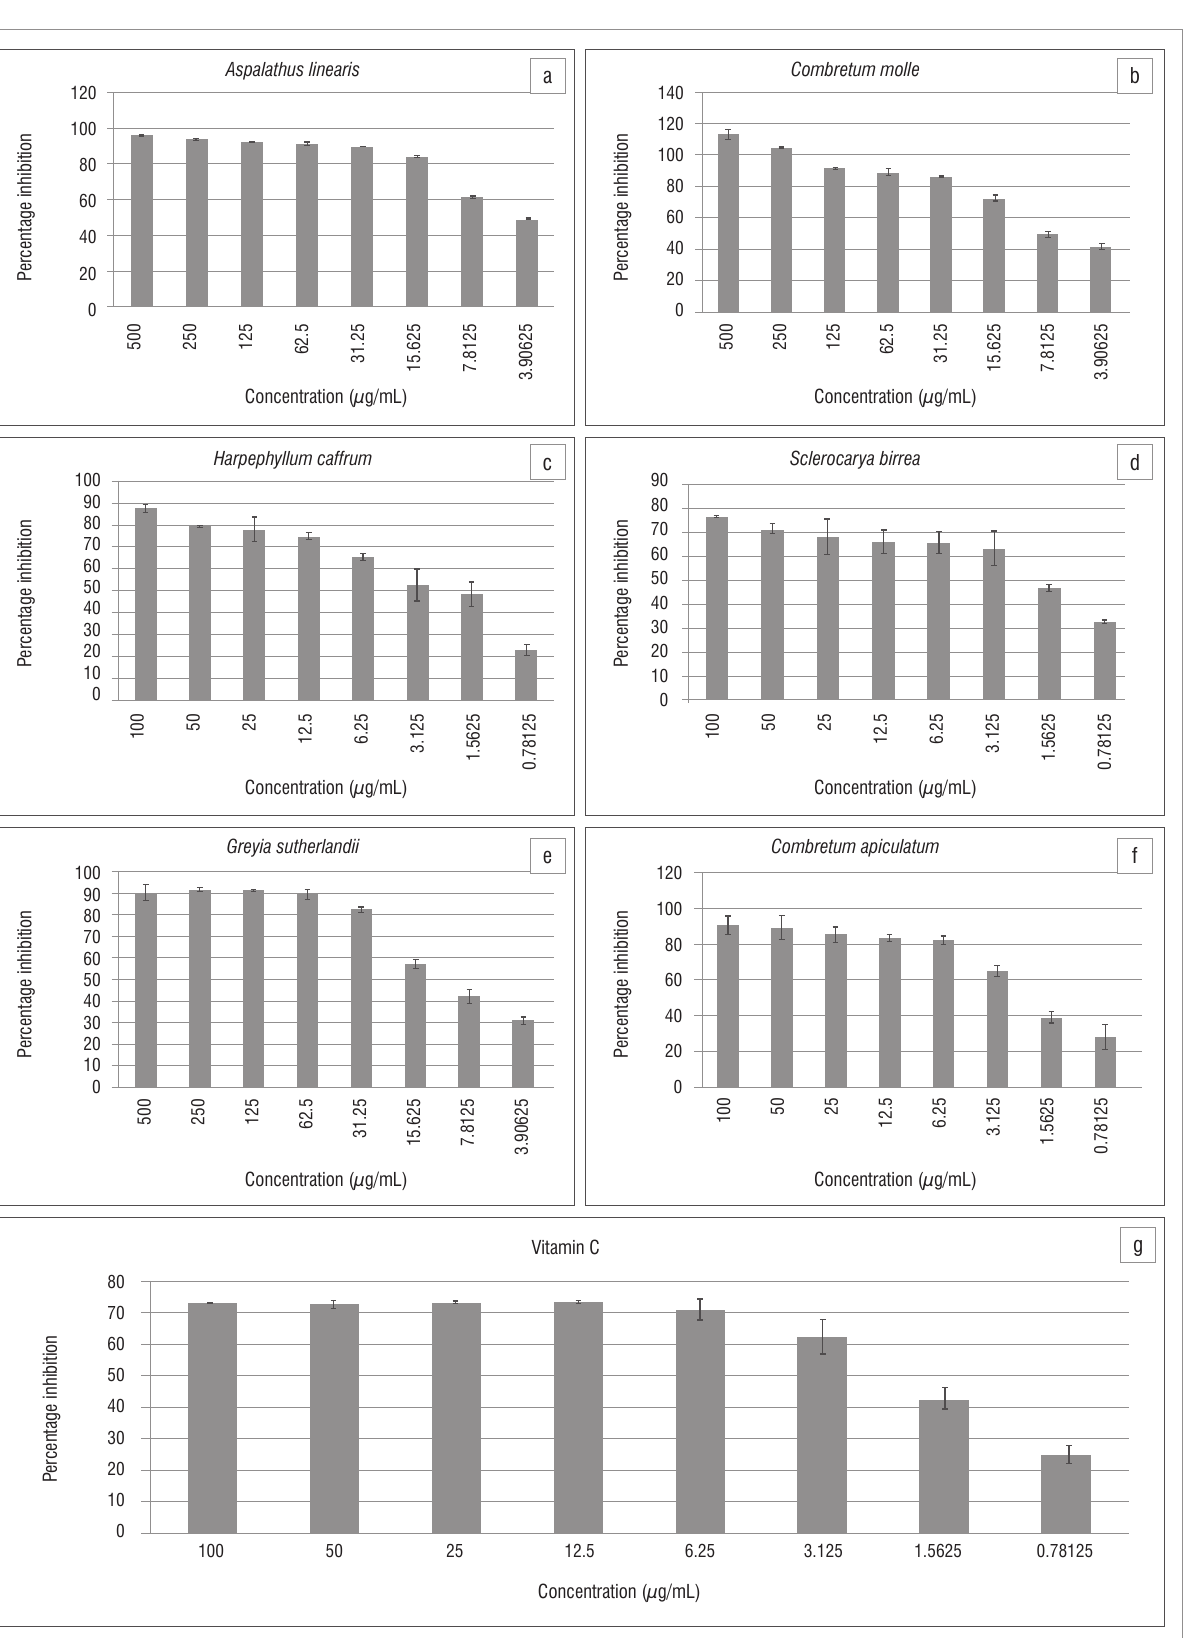
=9.83±0.8 µg/mL), (c) Harpephyllum caffrum (EC 50 =7.9±0.23 µg/mL), (f) Combretum apiculatum (EC 50